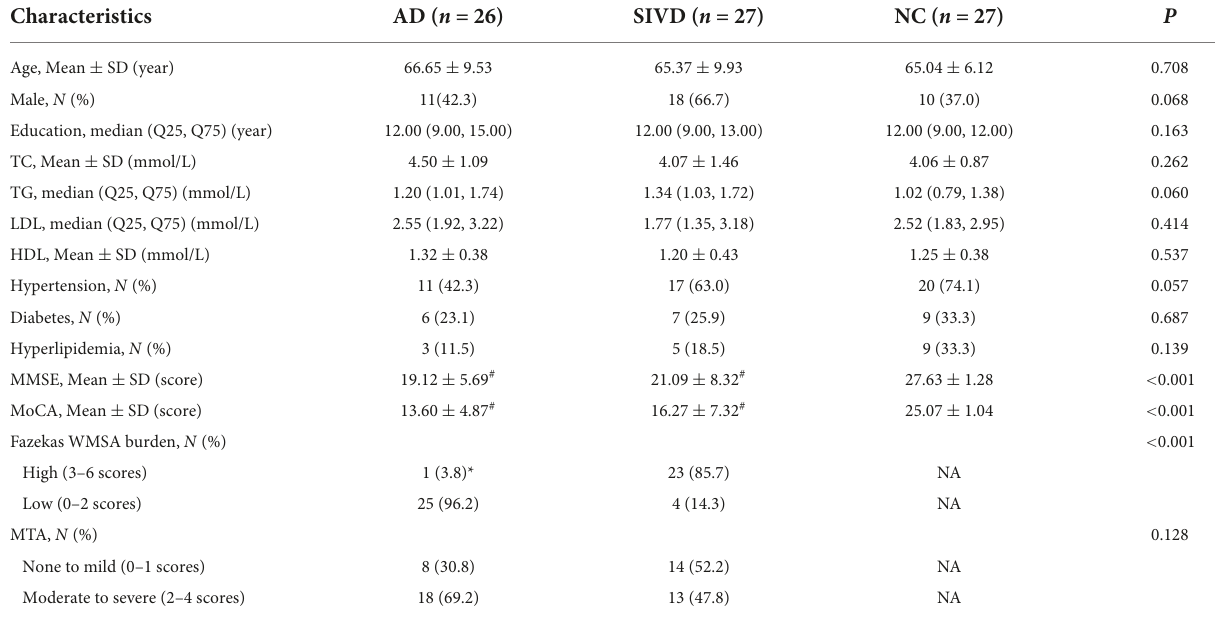
TABLE 1 Participant characteristics.